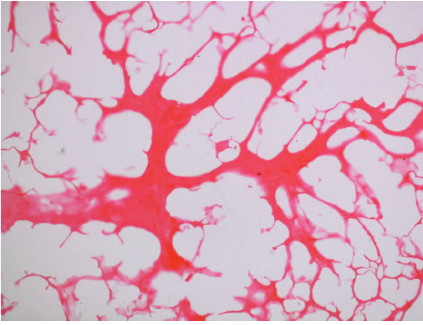
Figure 3: Marked liquefactive necrosis of neuropil with forma- tion of variable sized cystic spaces lined by thin and atrophied parenchymal septa containing remnants of neuropil and chronic inflammatory cells, chiefly fibroblasts. H&E ×